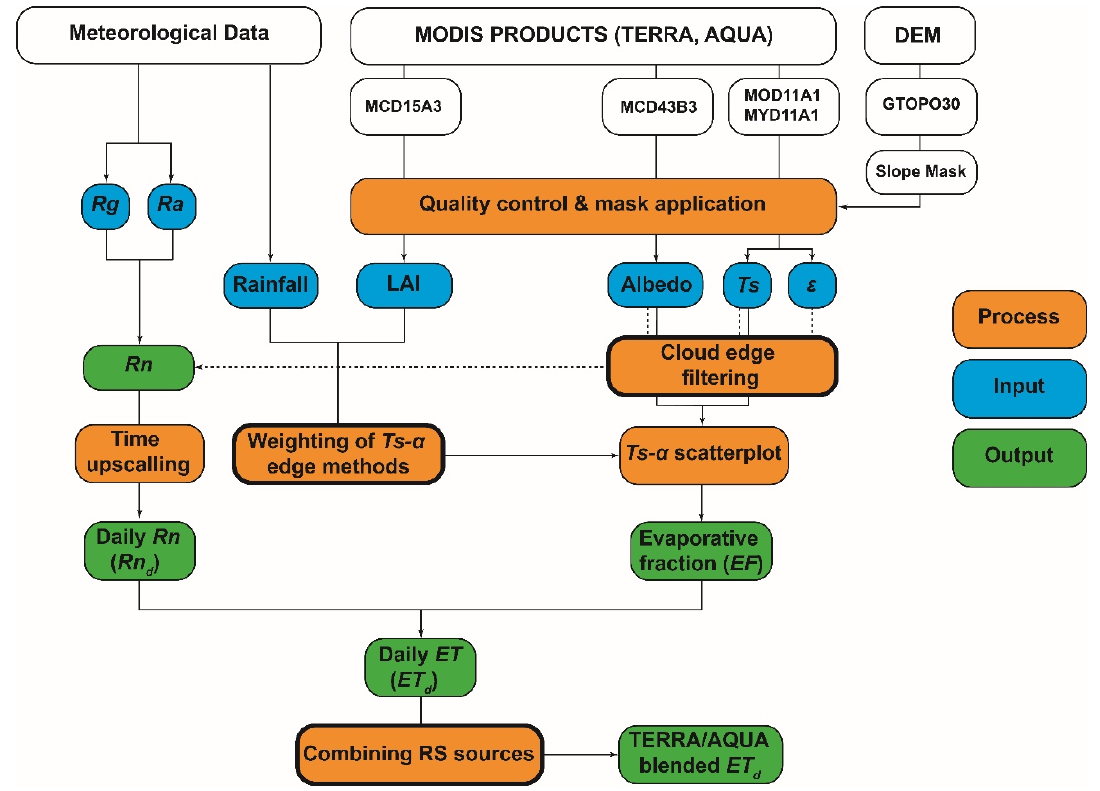
Figure 3. Flowchart of the E3S (EVASPA S-SEBI Sahel) method. Processes indicated in bold